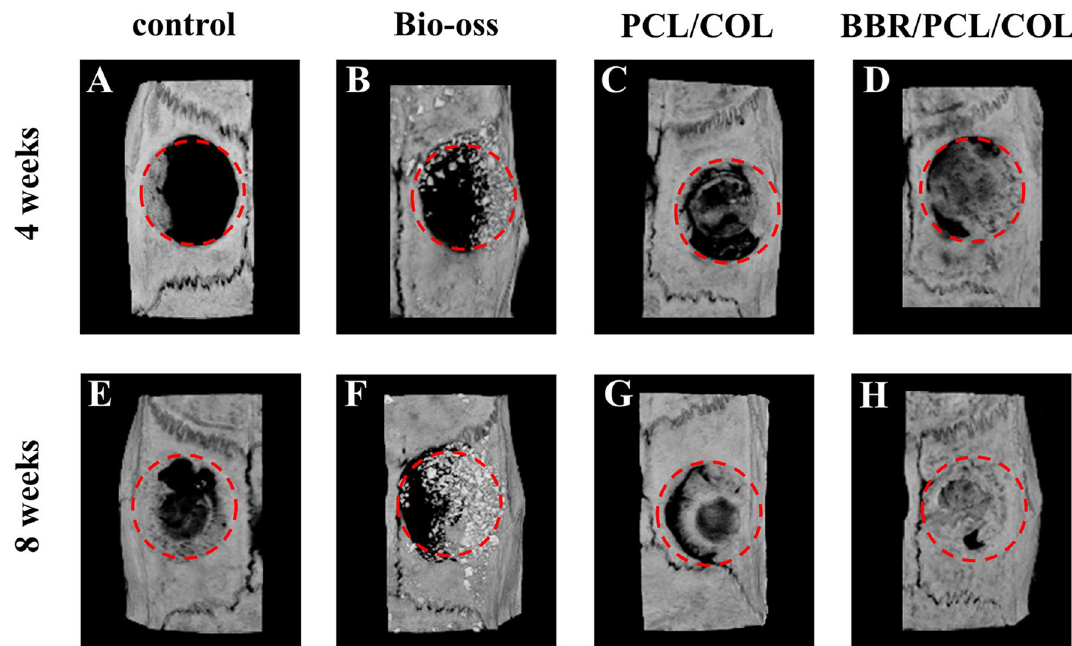
Figure 5. Images of micro-CT 3D reconstruction of rat calvaria defects at 4 weeks and 8 weeks after implantation.